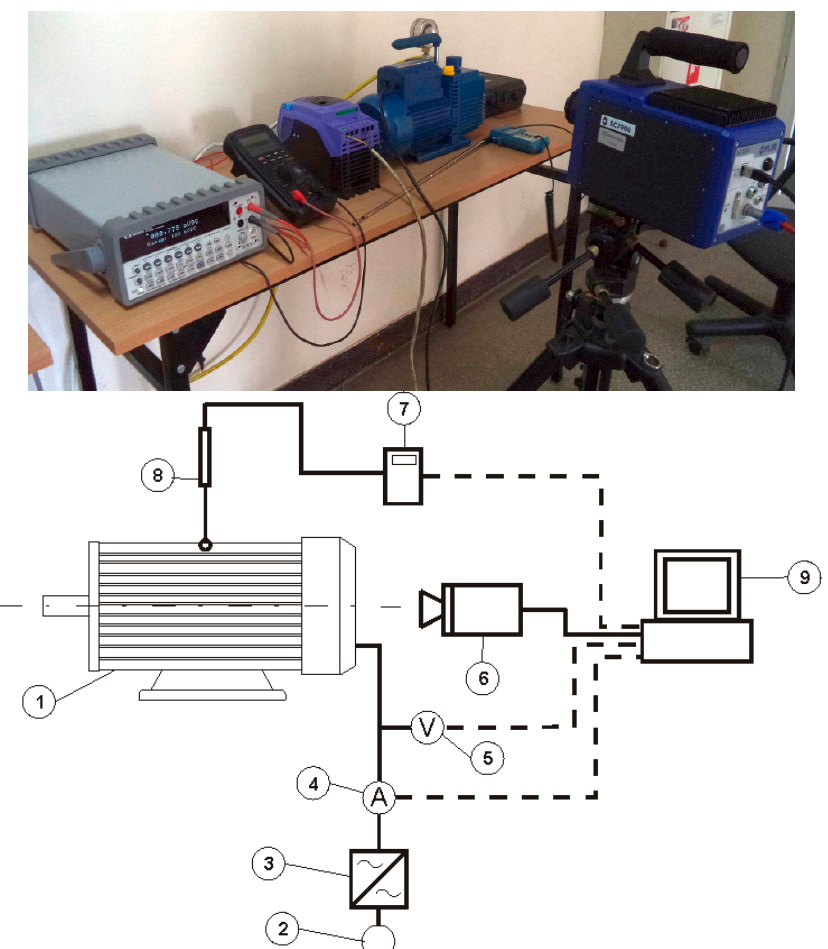
Figure 2. Scheme of the experimental setup. Markings: 1 Vacuum pump unit, 2 AC power, 3 Inverter (Invertek, Welshpool, UK), 4 Ammeter (Protek, Xiamen, China), 5 Voltmeter (Rigol, Beijing, China), 6 Thermovision camera, 7 Anemometer (TSI, St. Pauli, Shoreview, MN, USA), 8 Probe (TSI, St. Pauli, Shoreview, MN, USA), 9 PC (Lenovo, Beijing, China). The dashed line represents manual transfer of information.